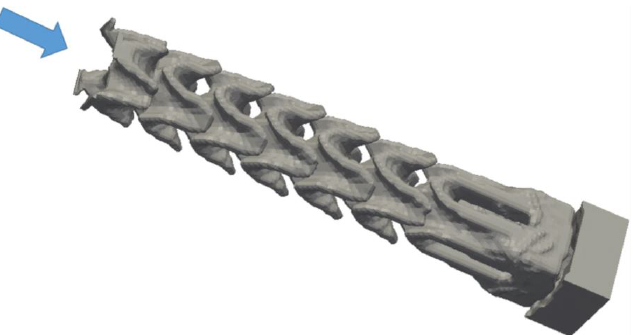
Figure 3. Illustration of the structure complexity of a microdevice in 3D. (Reprinted from Structural and Multidisciplinary Optimization , Volume 59, M. Pietropaoli, F. Montomoli and A. Gaymann, Three- dimensional fluid topology optimization for heat transfer, 801–812, Copyright (2019), with permission from Springer Open under the terms of the Creative Commons Attribution 4.0 International License: http://creativecommons.org/licenses/by/4.0/, accessed on 15 November